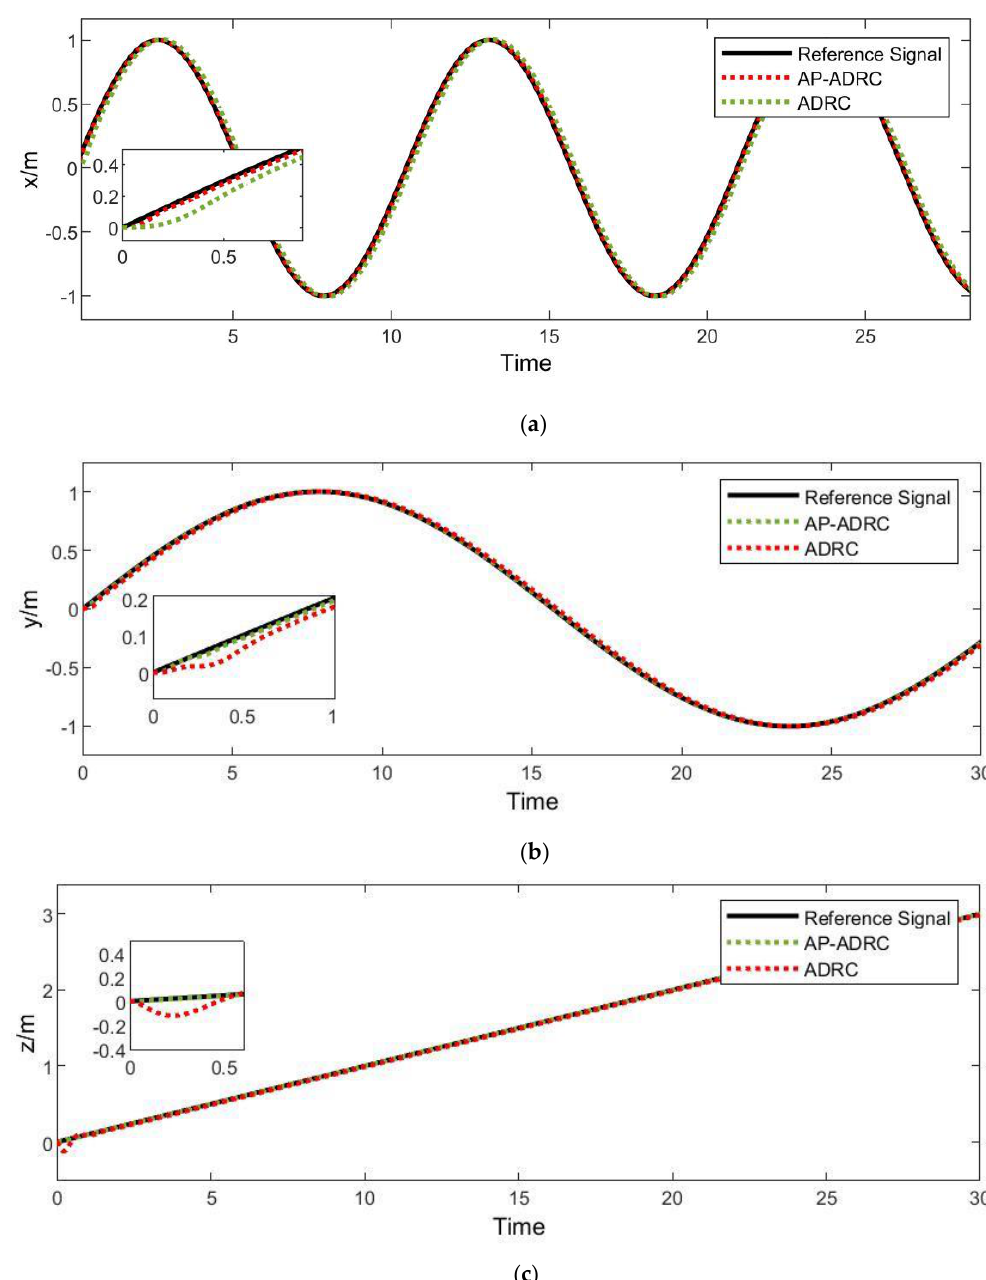
Figure 6. Response curves of position control under three disturbances. ( a – c ) are the tracking curves for each of the three position control channels.